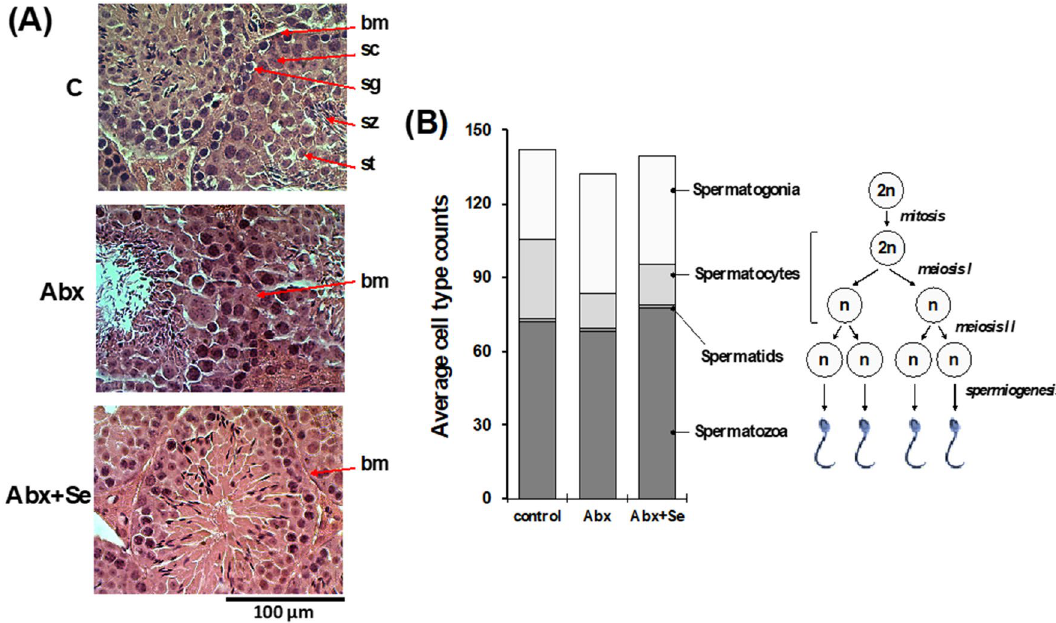
Figure 1. ( A ) Photomicrograph showing the cross section of H&E staining of the testes of a representative mouse from groups Control, C-Se, Abx and Abx + Se. The basement membrane (bm), spermatogonia cells (sg), spermatocytes (sc), spermatids (st) and spermatozoids (sz) are indicated by arrows. (400 × magnification). ( B ) Bar plots showing the average counts for each germ cell type in the seminiferous tubule; the scheme illustrates the process of generation of the different types of germ cells during spermatogenesis.